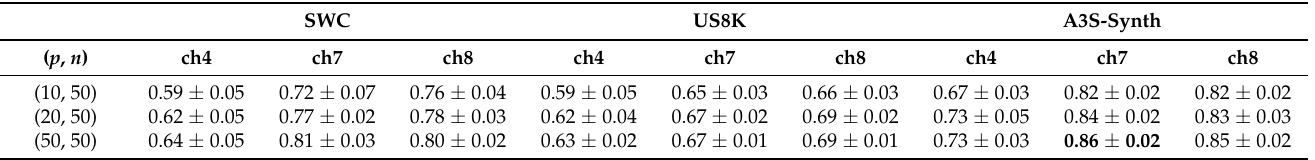
Table 8. A3S-Rec dataset: AUPRC of the best prototypical models across all the recordings of channels